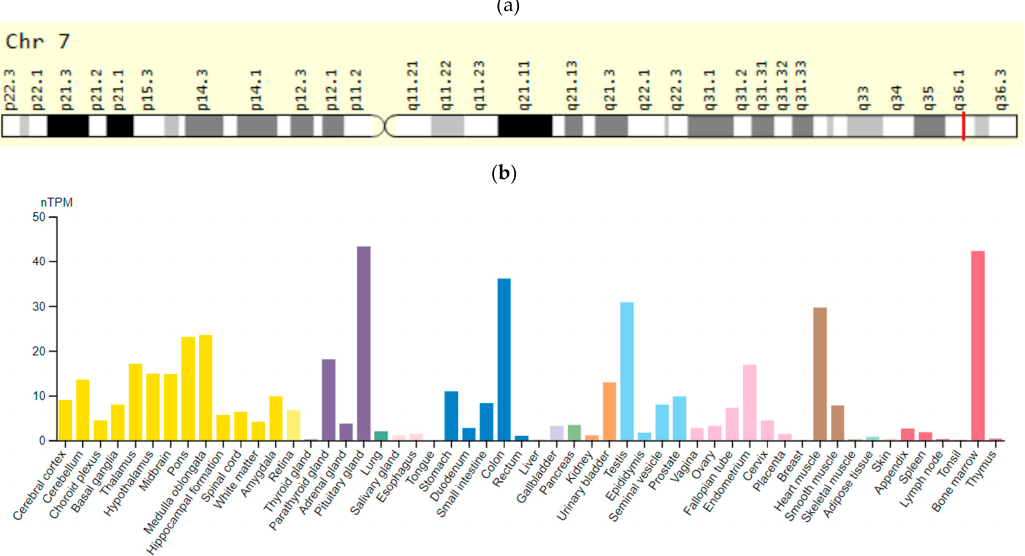
Figure 2. The KCNH2 (HERG) gene : ( a )–gene chromosome location; ( b )–protein expression in tissues of humans [52,53].